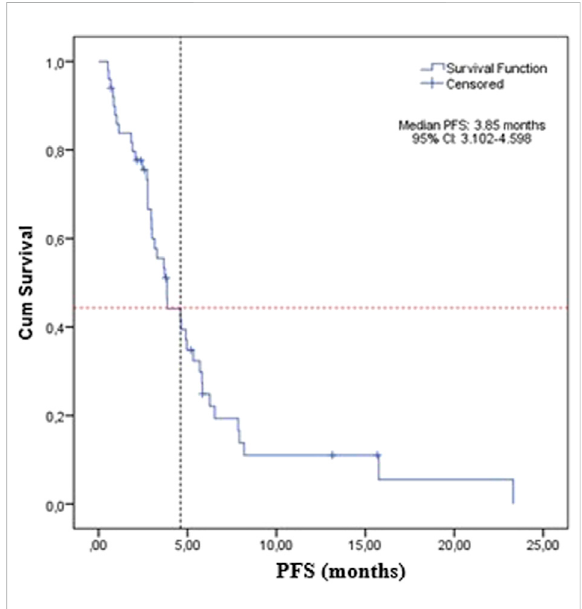
FIGURE 1 Progression-free survival of the sample treated with